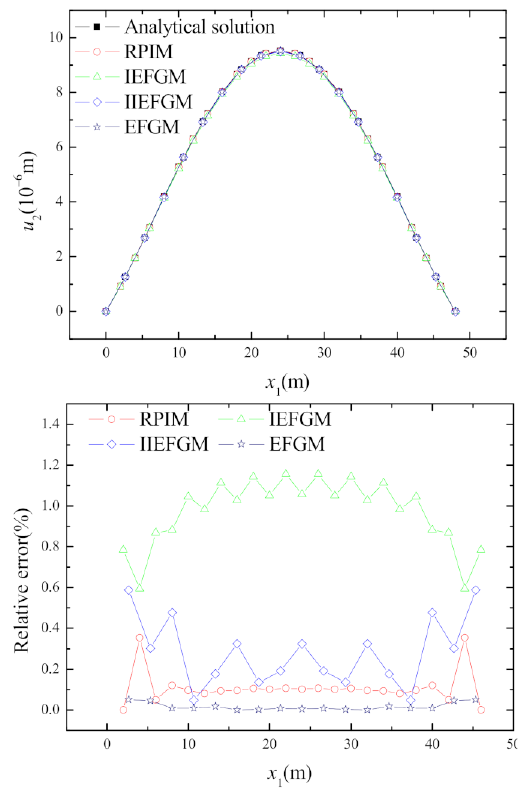
Figure 2. Deflection u 2 and its relative error at x 2 = 0 m .